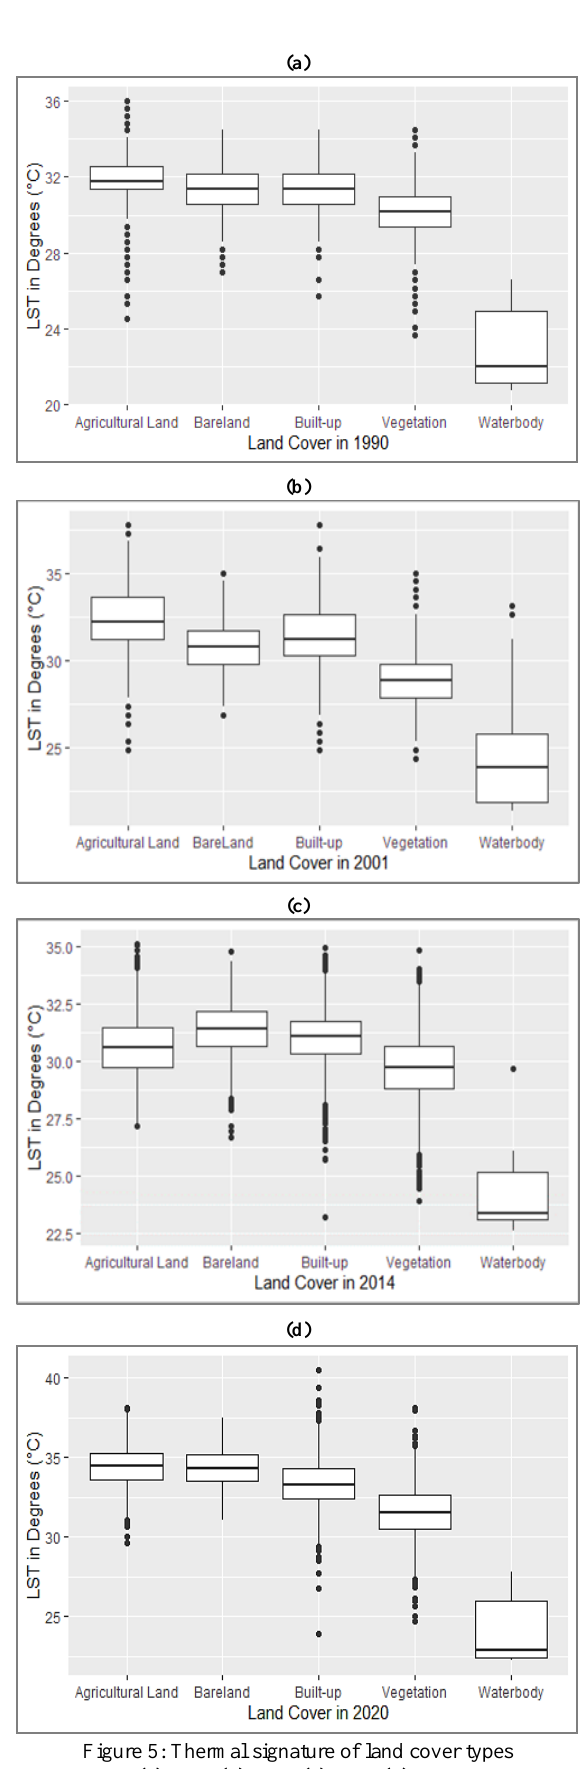
(a) 1990 (b) 2001 (c) 2014 (d)